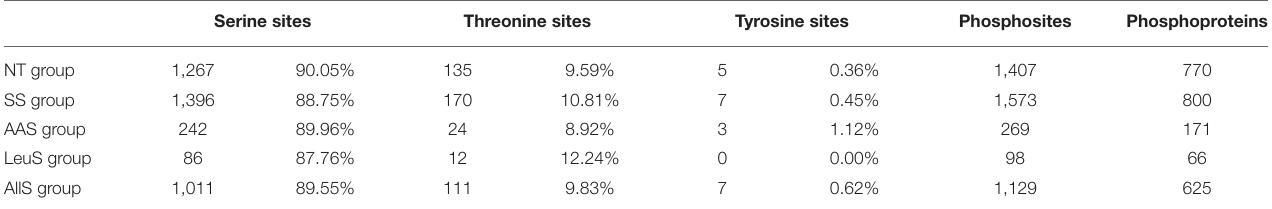
TABLE 2 | The compositon and number of phosphosites and